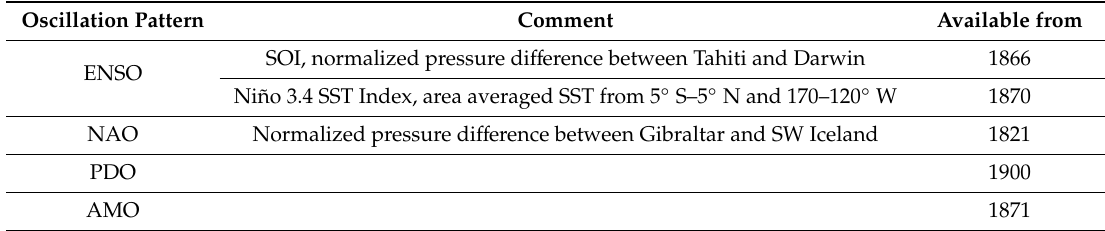
Table 1. Data sets of climate variability indices (monthly values) available at the US NOAA (National Oceanic and Atmospheric Administration) ESRL (Earth System Research Laboratory), under the GCOS (Global Climate Observing System) umbrella (https: // www.esrl.noaa.gov / psd / gcos_wgsp / Timeseries / SOI / or https: // www.esrl.noaa.gov / psd / gcos_wgsp / Timeseries / Nino34 / or https: // www.esrl.noaa.gov / psd / gcos_wgsp / Timeseries / NAO / or https: // www.esrl.noaa.gov / psd / gcos_wgsp / Timeseries / PDO /